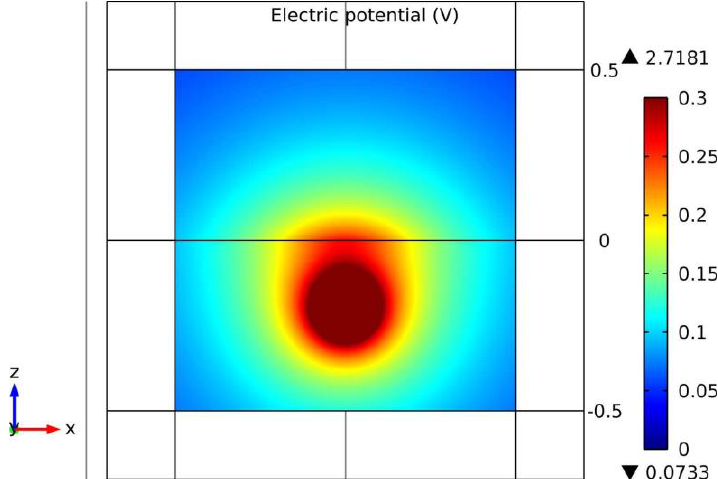
Figure 4. Numerically simulated electric potential distribution, for a single current source I with considered values I = 1 A and ξ = (0, 0, −20 cm) T .